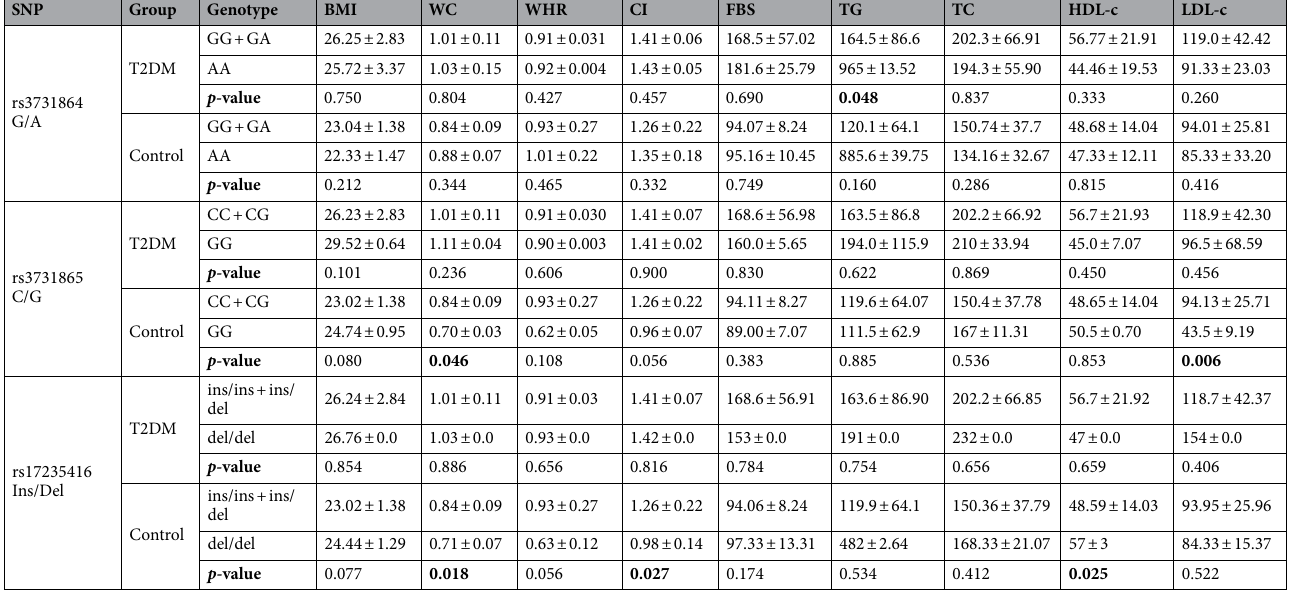
Table 3. Association between SLC11A1 variants and clinical-demographic characteristics of patients with T2DM and healthy subjects. T2DM Type 2 Diabetes Mellitus, BMI body mass index, WC waist circumference, WHR waist-to-hip ratio, CI conicity index, FBS fasting blood sugar, TC total cholesterol, TG triglyceride, HDL- c high-density lipoprotein c, LDL-c low-density lipoprotein c, Ins insertion, Del deletion. p -values < 0.05 were considered statistically significant and shown in Bold.